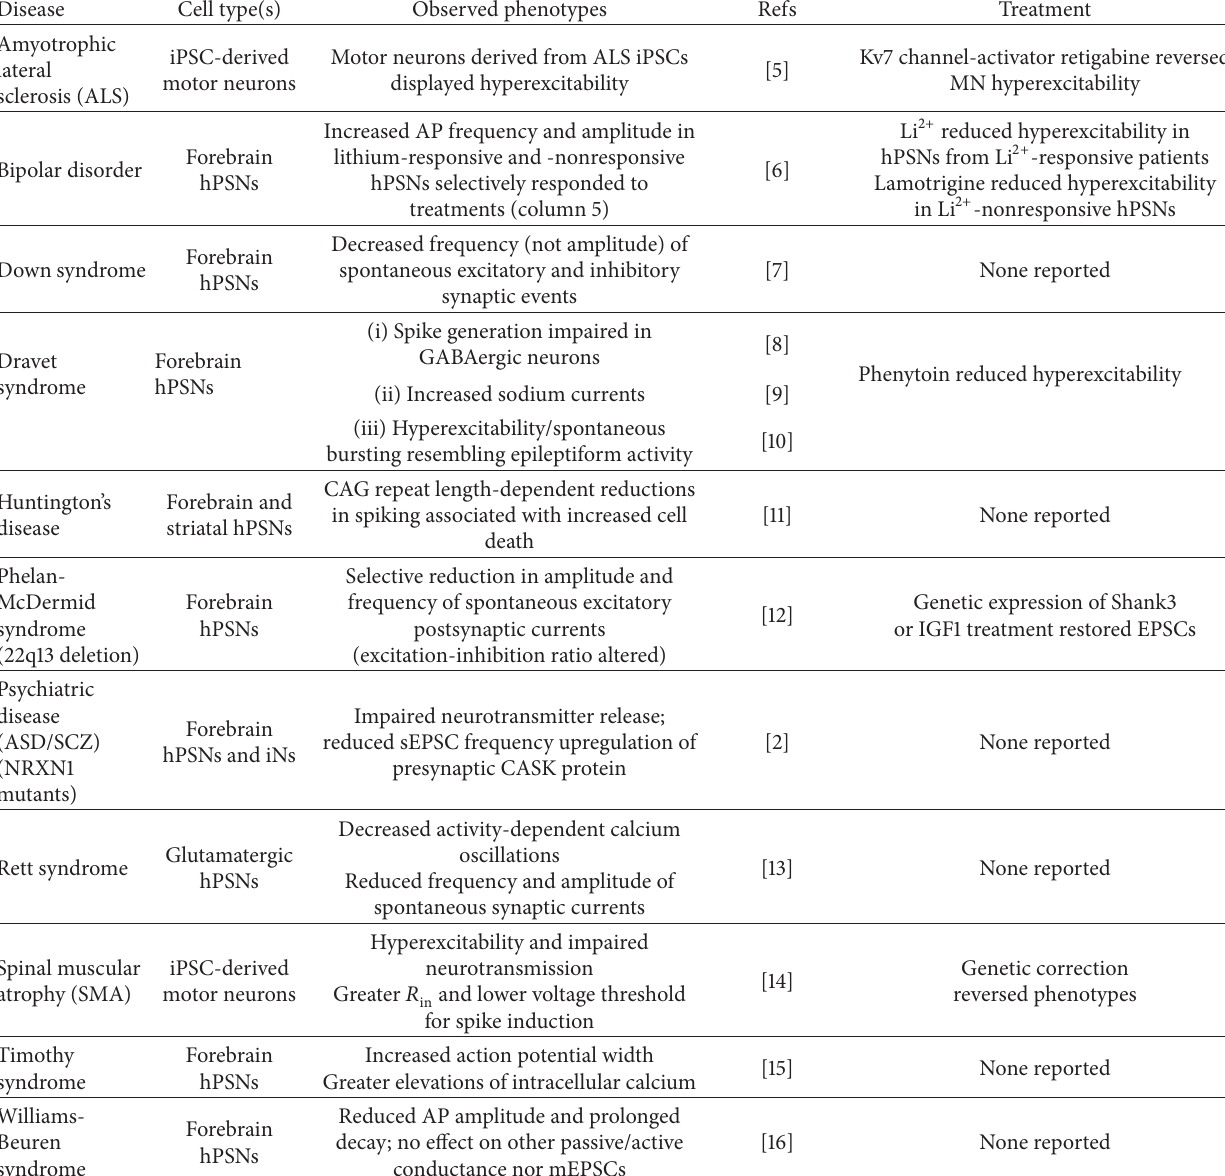
Table 1: Dysfunction and treatment of diseased human stem cell-derived